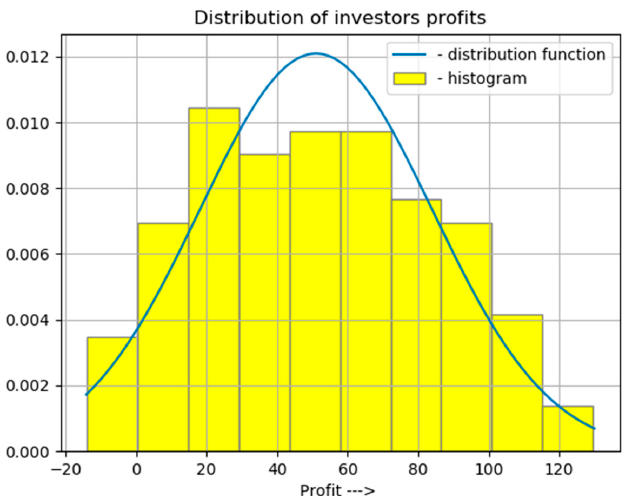
Figure 4. Histogram and theoretical curve of profit distribution of investors of projects of production of raw materials for bioethanol from wheat